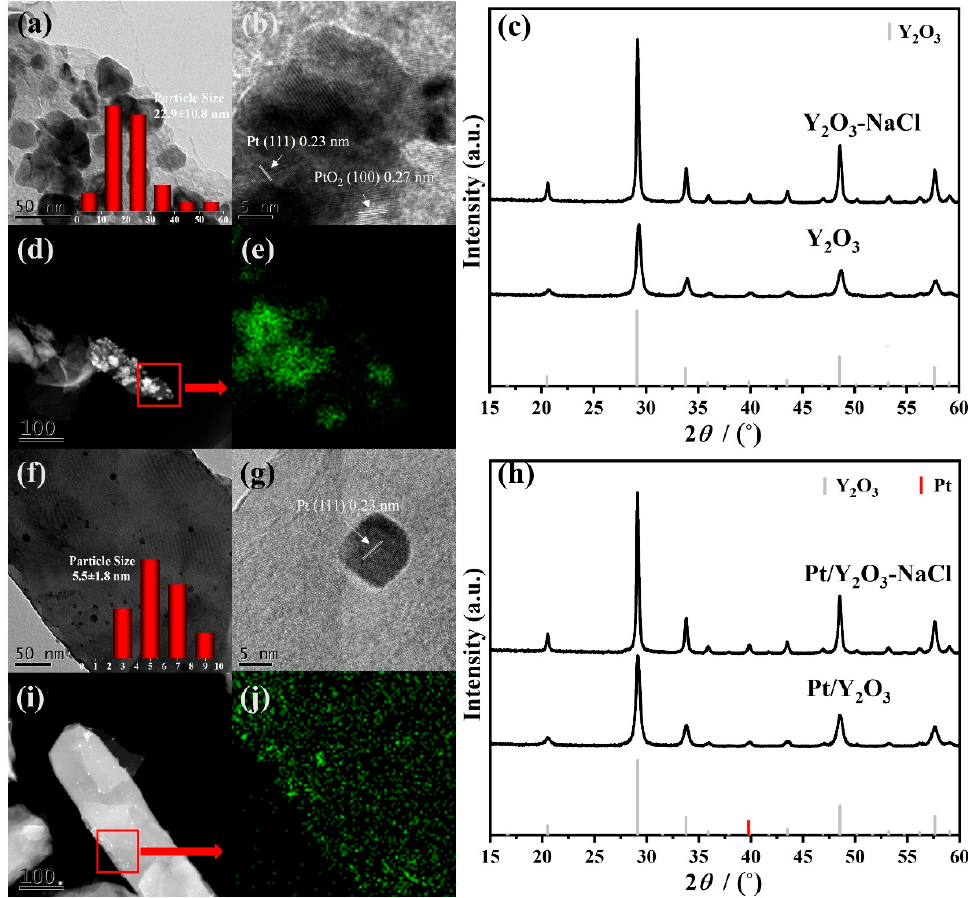
Figure 4. Structural characterization of supports and fresh catalysts. TEM ( a , f ) and HRTEM images ( b , g ), and HAADF-STEM images ( d , i ) and corresponding EDS mapping results ( e , j ) of fresh Pt/Y 2 O 3 ( a , b , d , e ) and Pt/Y 2 O 3 -NaCl ( f , g , i , j ), and XRD patterns of Y 2 O 3 -NaCl and Y 2 O 3 supports ( c ), and fresh Pt/Y2O3-NaCl and Pt/Y 2 O 3 catalysts ( h ).